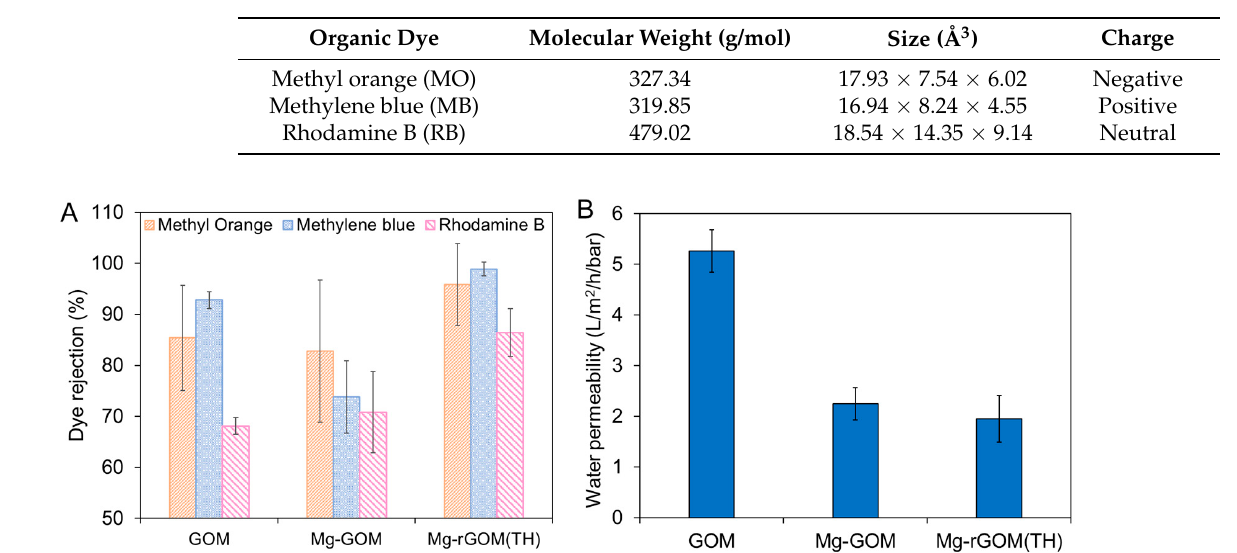
Figure 7. ( A ) Dye rejection rates and ( B ) pure water permeability of the GOM